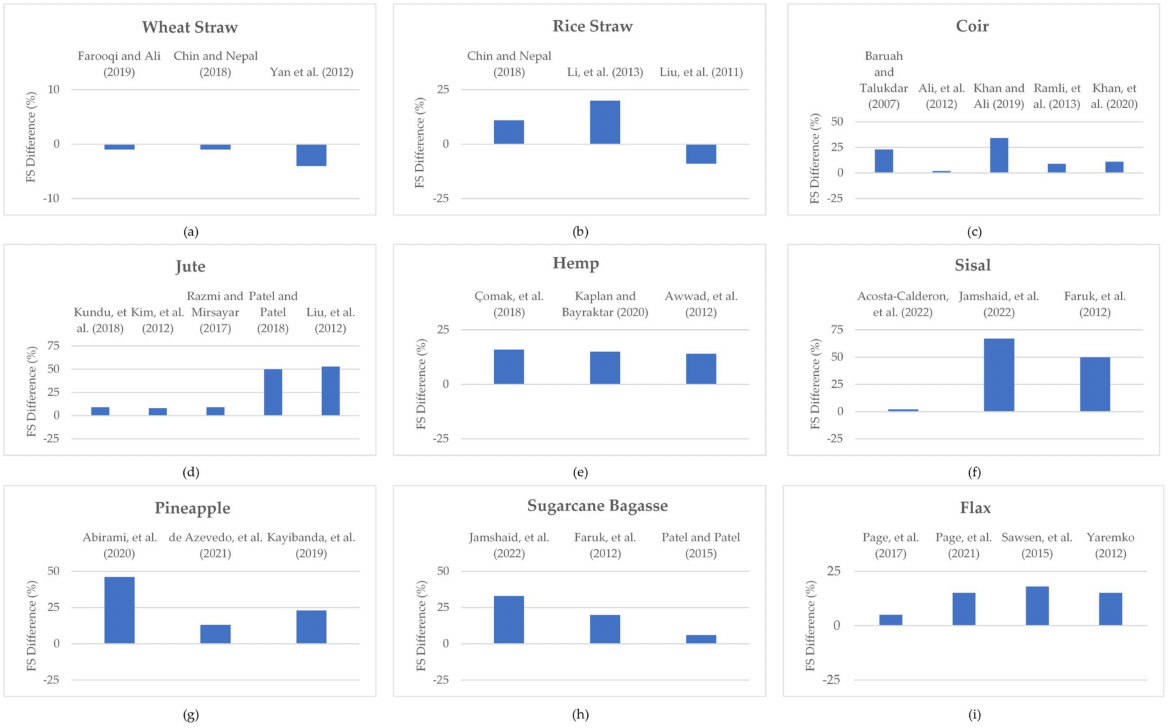
Figure 19. Percentage difference in flexural strengths of ( a ) Wheat straw, ( b ) Rice straw, ( c ) Coir, ( d ) Jute, ( e ) Hemp, ( f ) Sisal, ( g ) Pineapple, ( h ) Sugarcane Bagasse, and ( i ) Flax fiber reinforced cementitious composites with respective reference